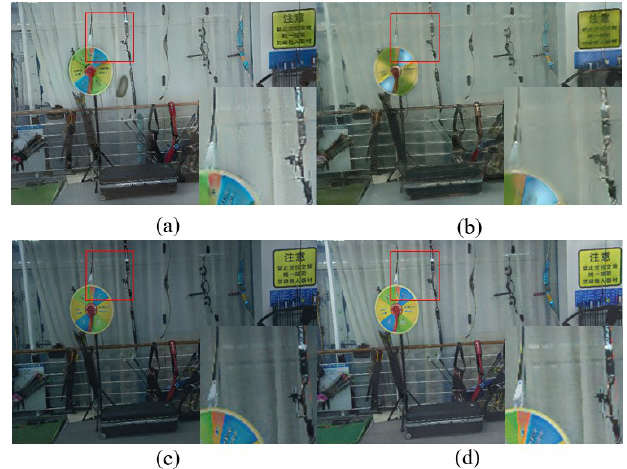
Figure 8. Visualization of the impact with different modules. ( a ) Backbone. ( b ) V1. ( c ) V2. ( d )